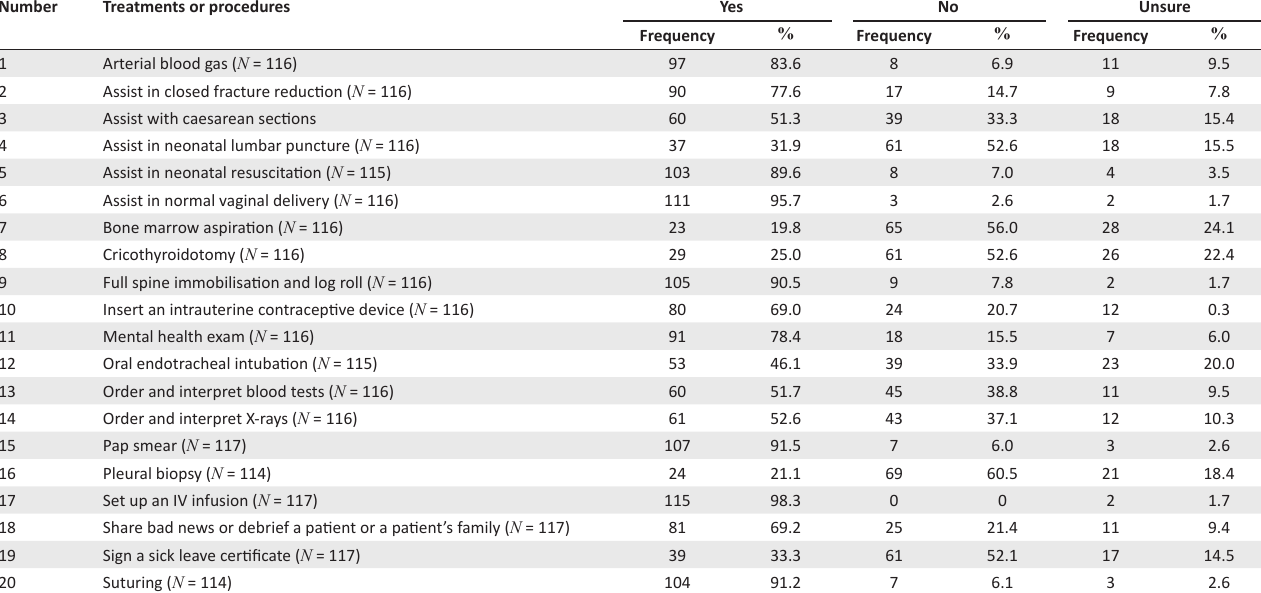
TABLE 1: Comparison of the responses to treatments or procedures presented as ‘A clinical associate can legally perform the following in accordance with their scope of work’. Number Treatments or procedures Yes Unsure